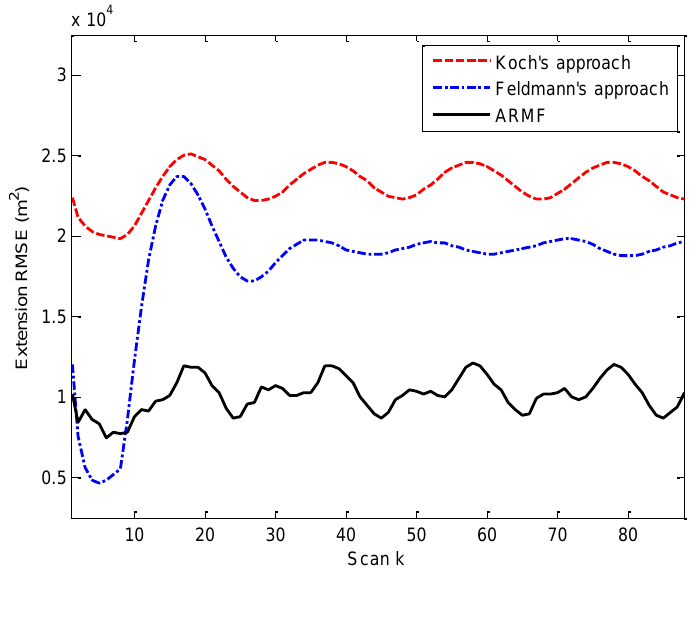
Figure 4. RMSE of physical extension in simulation scenario